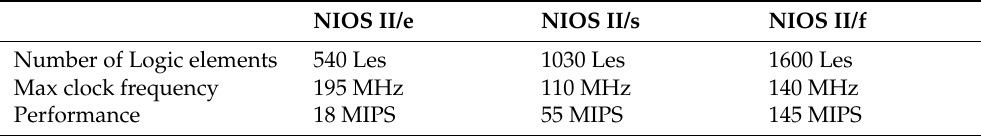
Table 3. Performances of each NIOS II